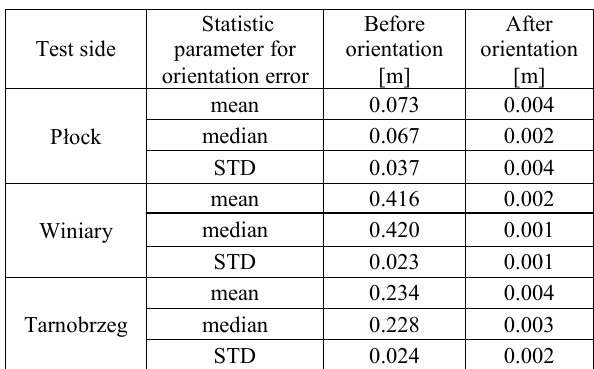
Table 3. The vertical displacement between the ULS and TLS data for single planes in the Płock test site